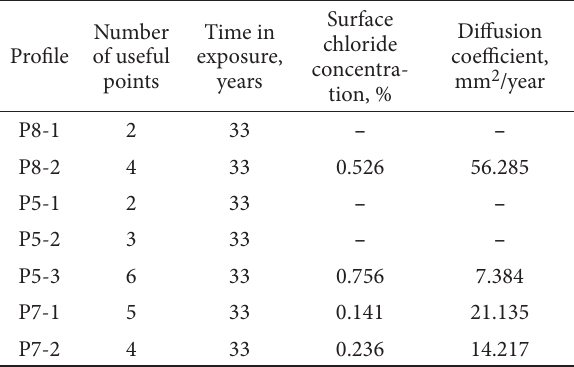
table 2. Results of diffusion coefficient calculations at deterministic